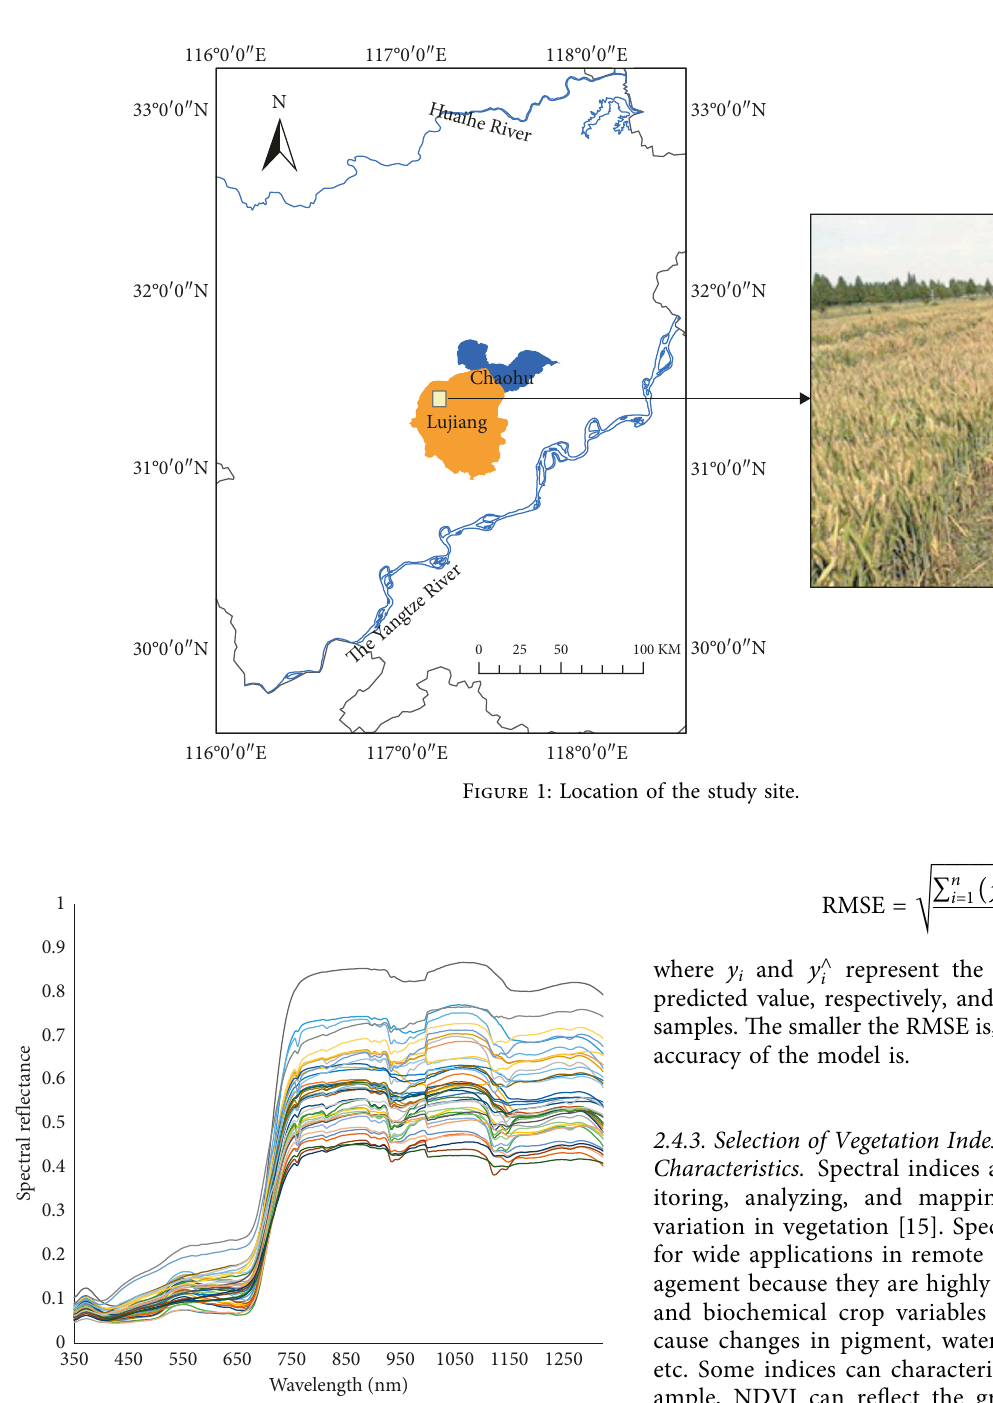
Figure 2: Spectral reflectance curves of 41 wheat ear